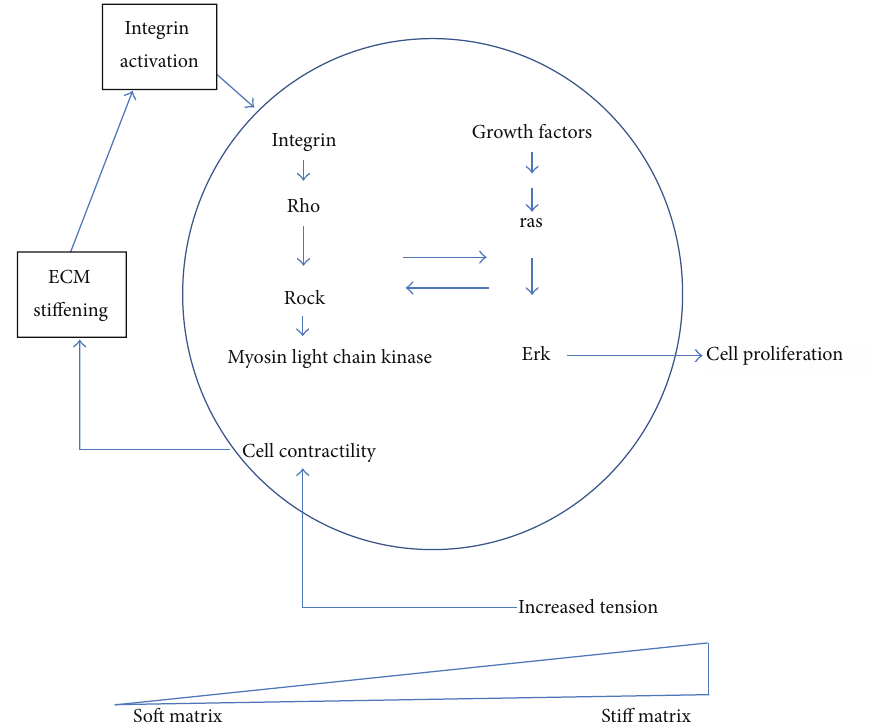
Figure 2: Elements of mechanical signaling. A simplified pathway of mechanical signaling in cells is depicted. As the cell cytoskeleton contracts (a process called cell contractility) and ECM accumulates in the cell microenvironment, integrin activation occurs leading to activation of Rho (as discussed in [1]). Rho in turn activates ROCK leading to activation of ras. In fibroid cells obtained either at the time of hysterectomy or myomectomy, RhoA activity is attenuated. This adaptation of the fibroid cell is not ROCK dependent (as discussed in [2]). These findings suggest that fibroid cells in symptomatic tumors where treatment was needed are fundamentally adapted to their stiff microenvironment and thus become insensitive to moderate mechanical cues. It is not certain when in the natural history of fibroid development that this adaptive response to mechanotransduction occurs. Nevertheless, mechanical sensing does occur in fibroid cells.